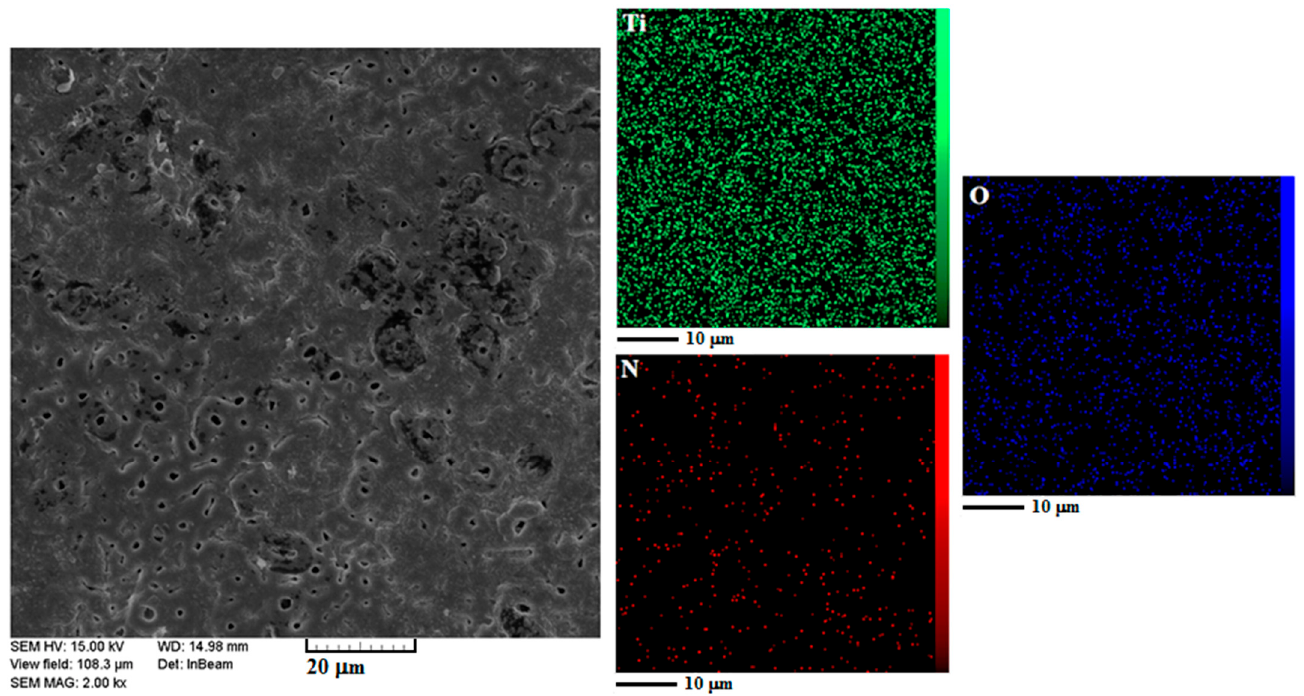
Figure 3. The elemental distribution map of Ti/TiO 2 -N sample surface.